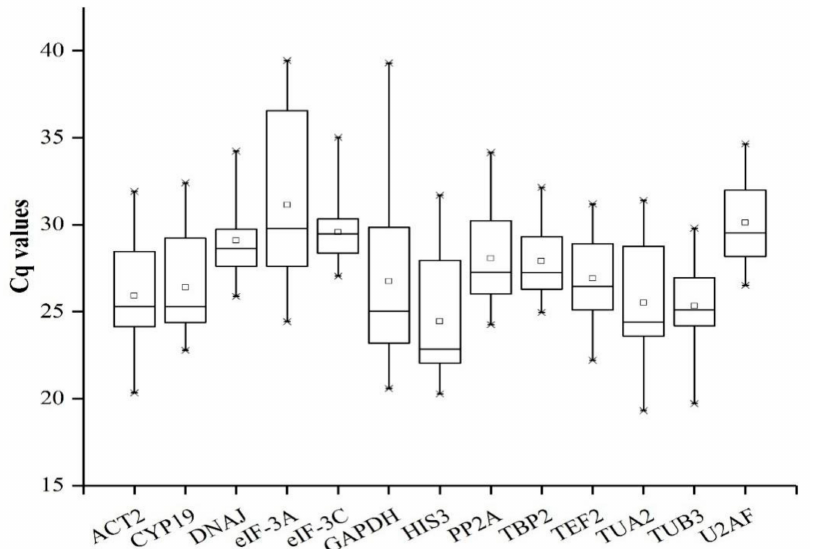
Figure 2. RT-qPCR Cq values for all candidate reference genes in all E. sibiricus samples. Whisker caps, boxes, lines, and square boxes represent maximum / minimum, 25 / 75 percentiles, median, and mean,